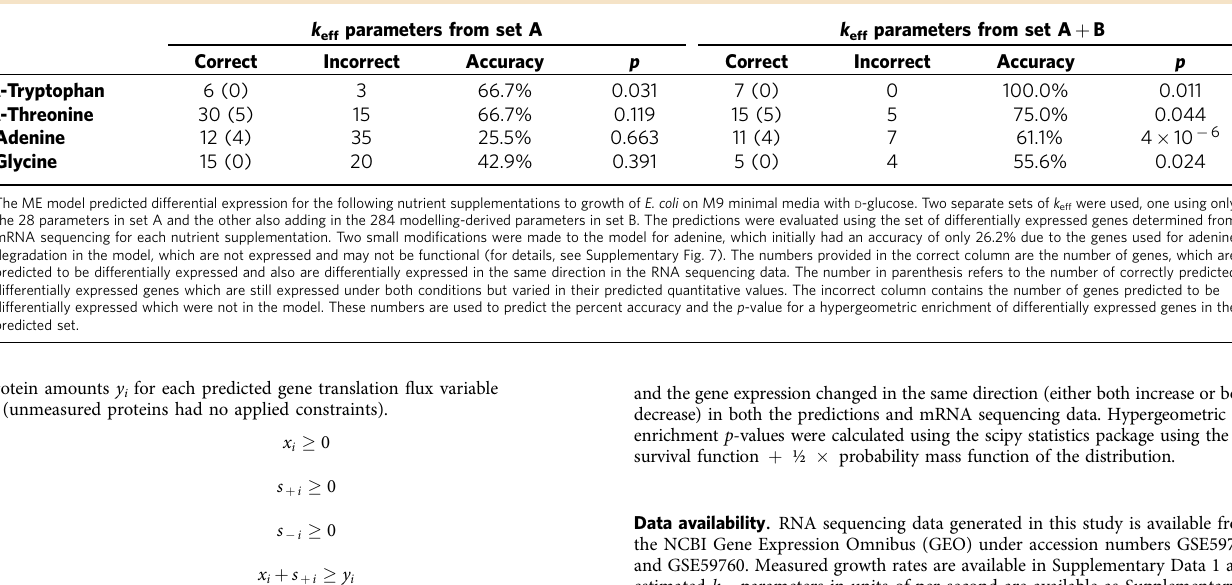
Table 1 | Predicted expression changes confirmed